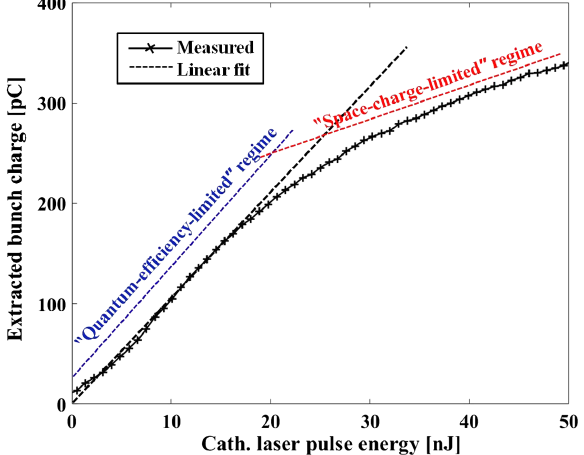
FIG. 8. The measured bunch charge as a function of the cathode laser pulse energy when the rf gun is operated at the MMMG phase.